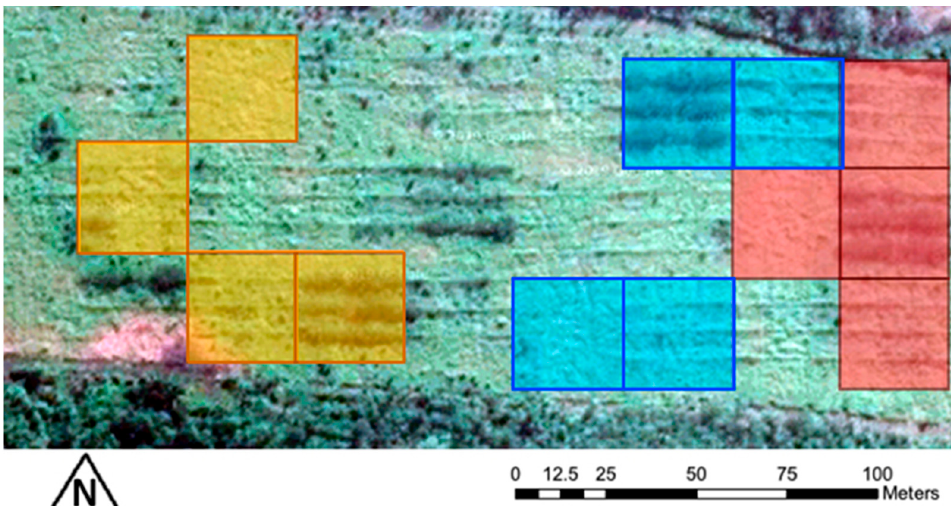
Figure 1. Satellite image and map of the random blocked experimental design for the cattle browsing trial. The trial was conducted from East to West in three phases, each of the four treatments (two cattle per plot) was replicated in each phase, phase 1 (red), phase 2 (blue) and phase 3 (yellow). (Map data: Google, Maxar Technologies).